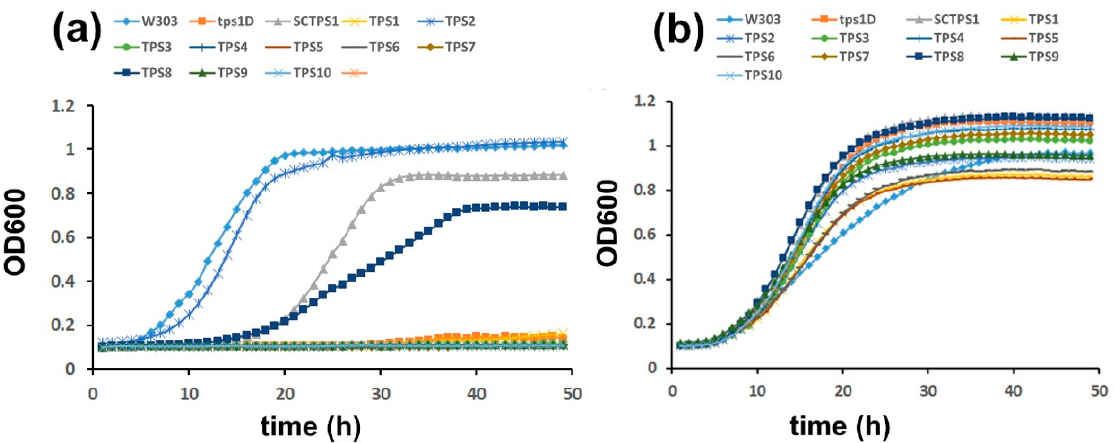
Figure 3. Sl TPS2 and Sl TPS8 display heterologous trehalose-6-P synthase (TPS) activity when grown in liquid culture. For growth curves, pre-cultures were diluted to OD600 = 0.05 and subsequent growth was followed by monitoring OD600 for 48 h. ( a ), Growth on glucose ( b ), Galactose control. The experiment was carried out three times with similar results. A representative data set is shown.